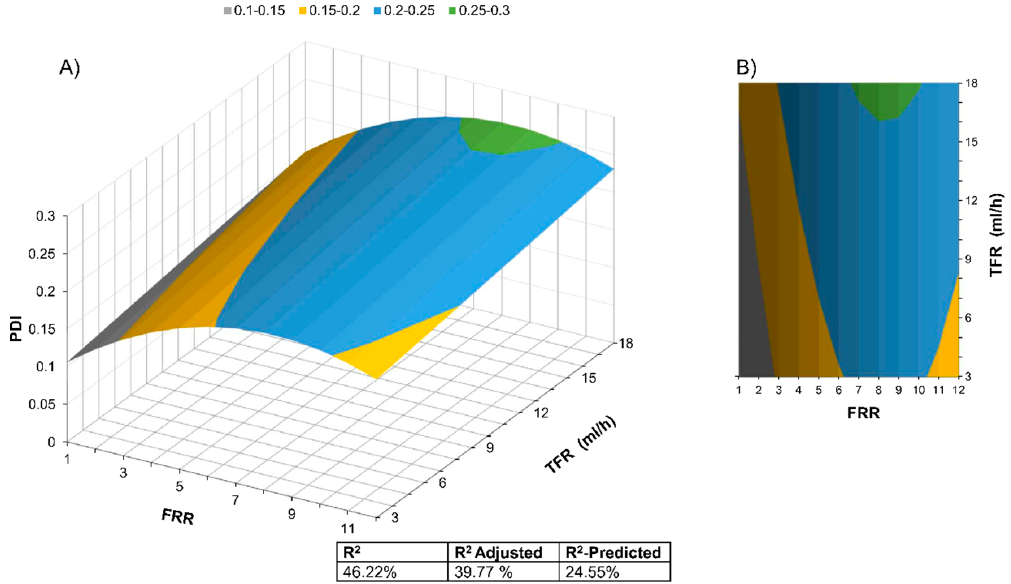
Figure 4. PDI Surface Response Model as well as the R 2 , R 2 ‐ adjusted, and R 2 ‐ predicted. The model has a p < 0.05. ( A ) 3 ‐ dimensional, ( B ) Contours representation.